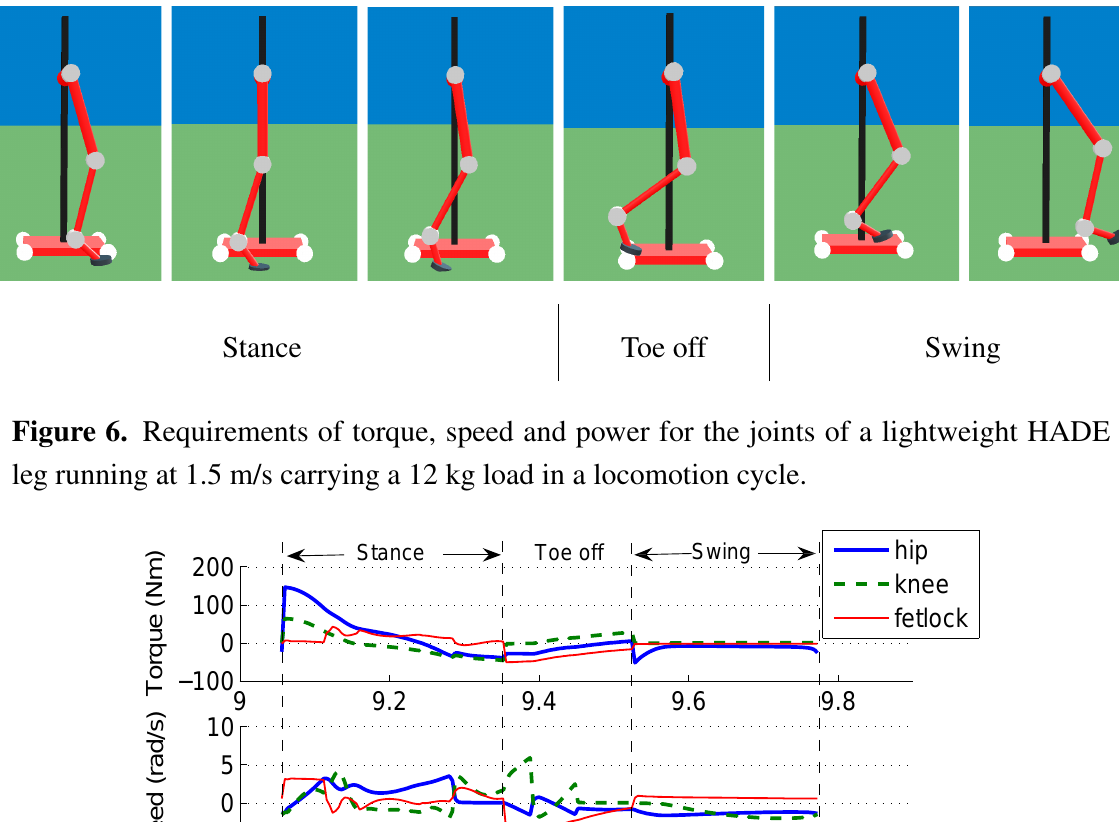
Figure 5. Sequence of the locomotion cycle simulation.